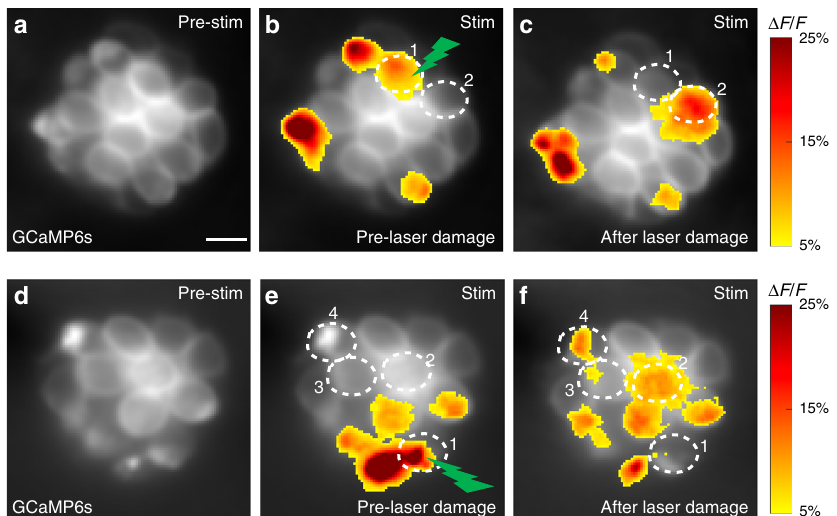
Fig. 7 Laser damage to an active cell activates silent cells. a – f Presynaptic GCaMP6s signals from two representative neuromast organs before and after laser damage. b , e Presynaptic Ca 2 + signals during a 2-s step stimulus (anterior and posterior responses are merged in the pro fi le) prior to laser damage. Spatial patterns of GCaMP6s Ca 2 + signals during stimulation are colorized according to the Δ F / F heat map and superimposed onto baseline GCaMP6s images ( a , d ). c , f Presynaptic Ca 2 + signals after high power laser-induced damage to one active cell in each neuromast (green lightning bolt, cell 1 in b and e ). After laser damage, the damaged cell (cell 1) no longer displays a detectable presynaptic Ca 2 + signal, but new cells now display robust presynaptic Ca 2 + signals (cell 2 in c and cells 2 – 4 in f ). Scale bars = 5 μ